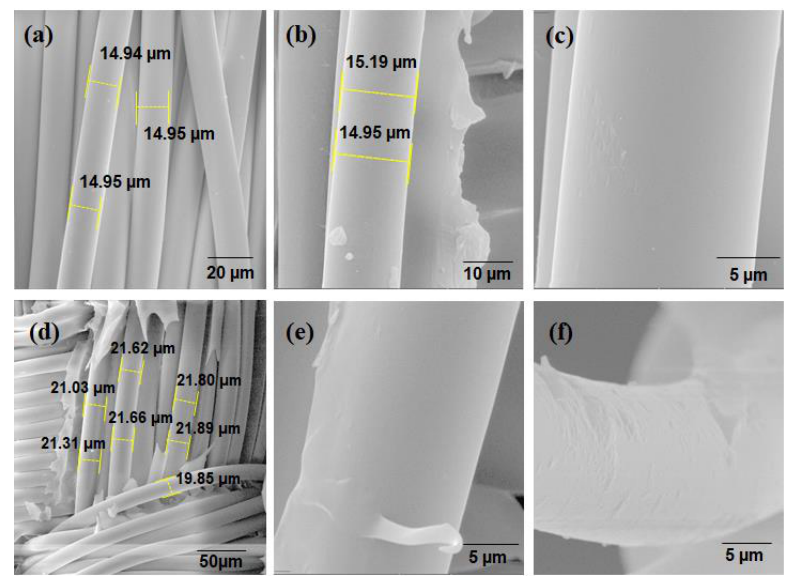
Figure 7. SEM images of fiber PET-fabric: ( a ) Unmodified PET, ( b ) and ( c ) UV PET 95:5:0.5 , ( d ) and ( e ) γ60 PET 100:0:50 , ( f ) γ60 PET 90:10:30 .